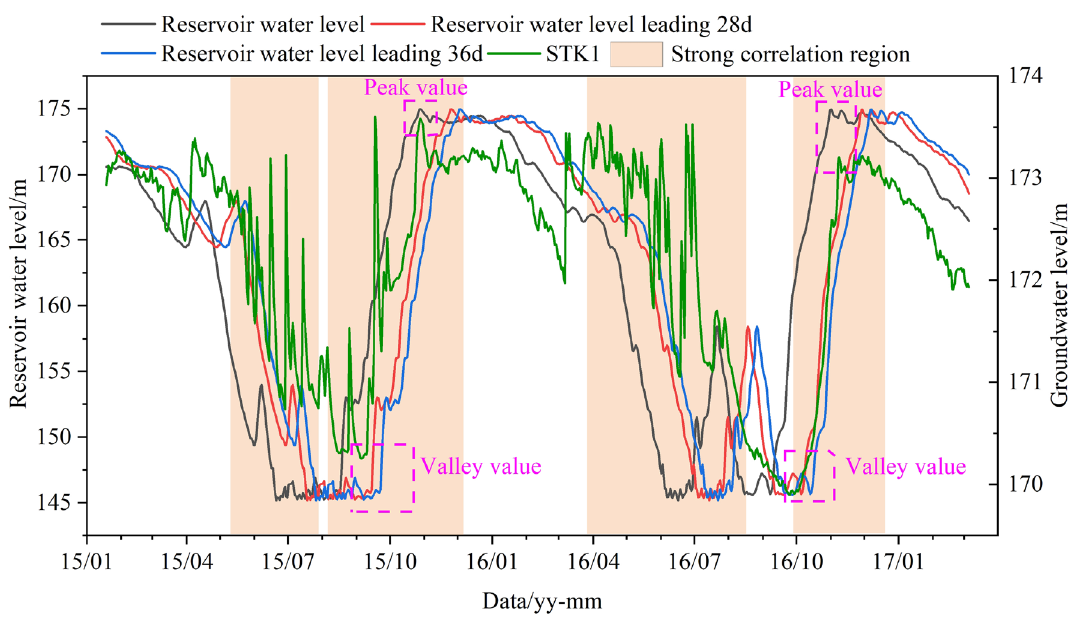
Figure 14. The curve chart of leading reservoir water level and groundwater level in